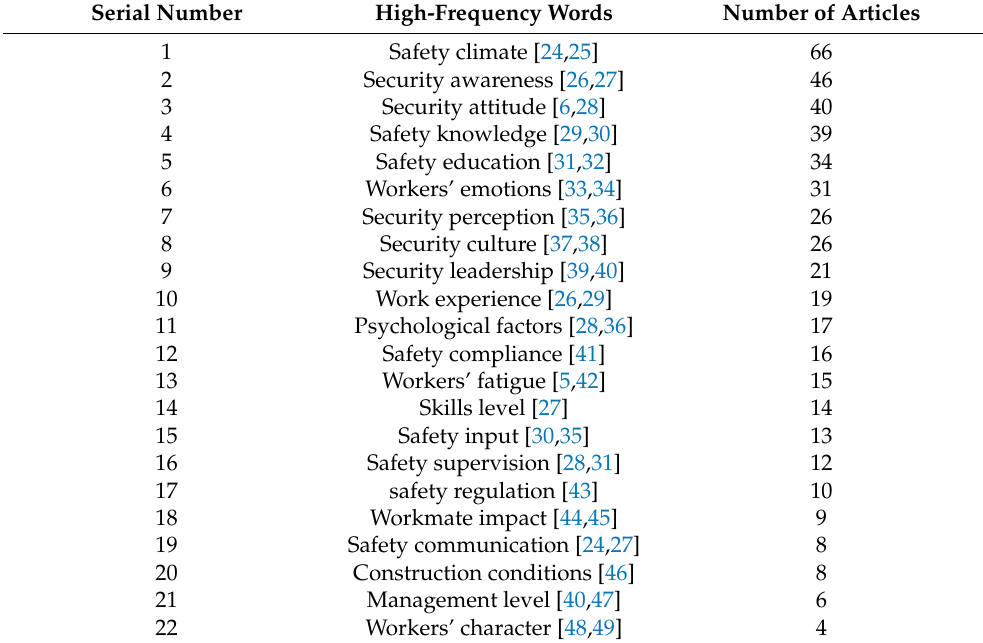
Table 1. High-frequency influencing factors.